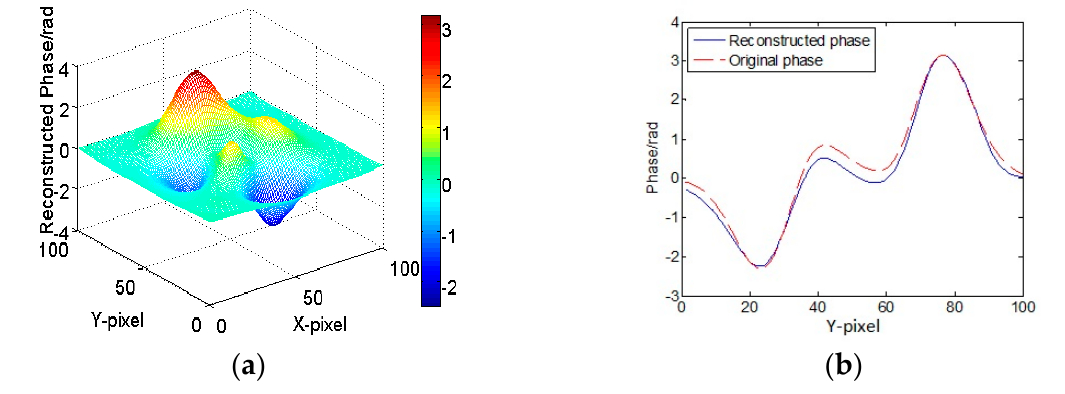
Figure 3. Reconstructed phase using our proposed method. ( a ) 3D reconstructed phase distribution; ( b ) Phase line trace along Y at X-pixel = 50 on Figure 3a (blue curve) and the same section of the original phase (red curve).